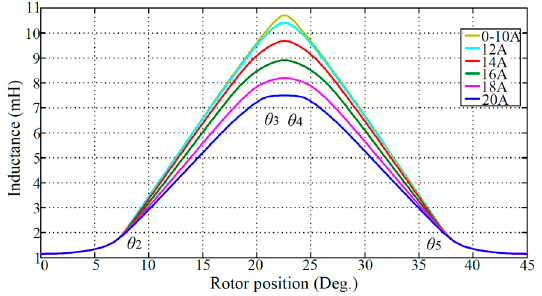
Figure 4. Inductance curve of SRM winding under different